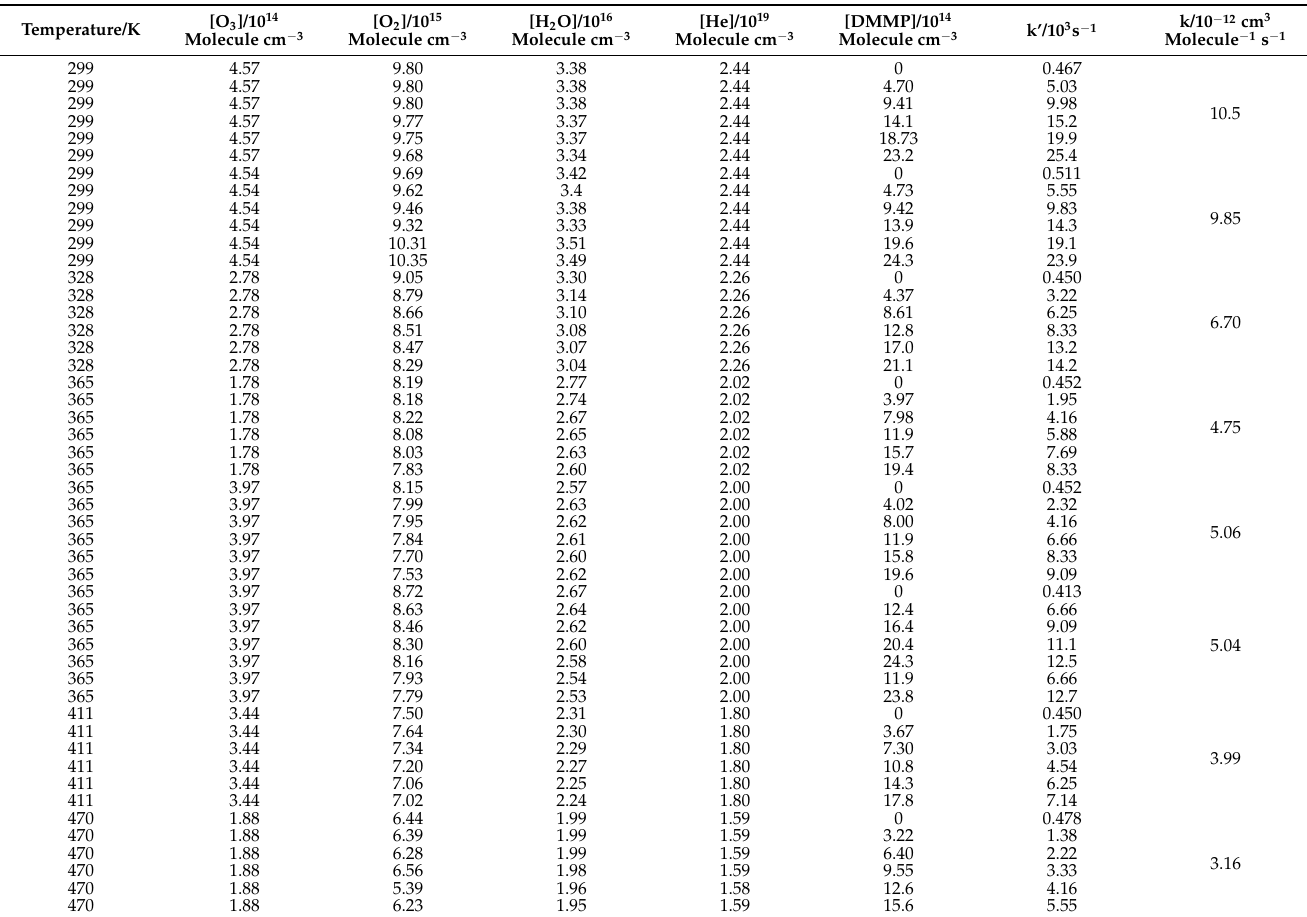
Table 1. Experimental conditions for the experiments with O 3 /O 2 /H 2 O/DMMP/He + 266 nm. All measurements at 1.00 ± 0.02